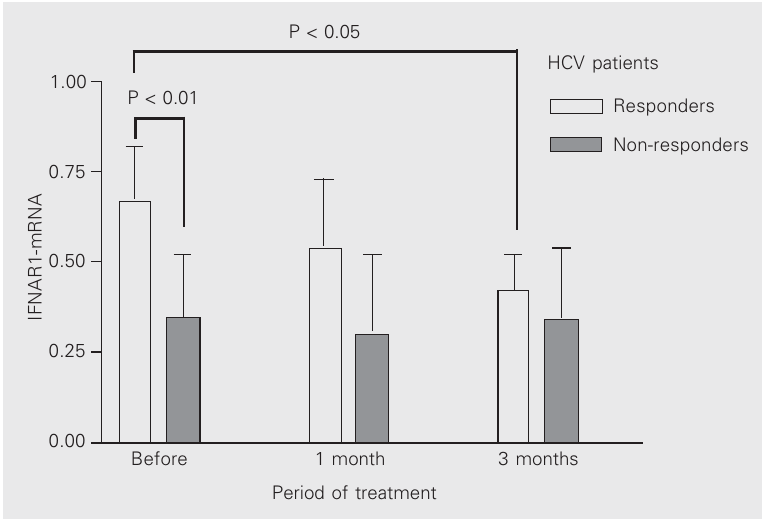
Figure 1. Interferon- α -receptor 1-mRNA (IFNAR1-mRNA) levels in peripheral blood mono- nuclear cells from 5 responder (open columns) and 12 non-responder (filled columns) patients with chronic hepatitis C before and during a three-month period of interferon- α therapy. Data are reported as means ± SD and compared by the Student t -test. Compari- sons are indicated in the Figure. Responder = normal ALT and negative RNA-HCV in serum, and non-responder = abnormal ALT and positive RNA-HCV, after